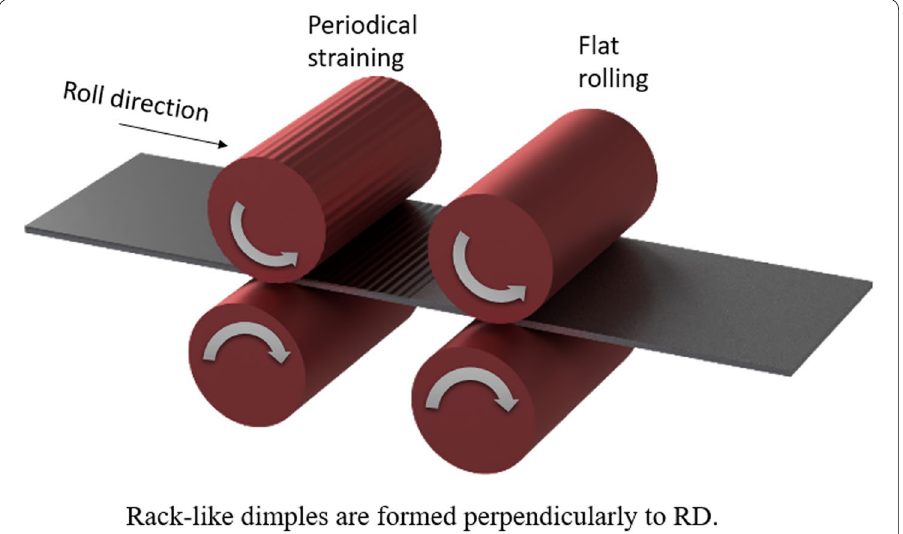
Fig. 6 Schematic illustration of the two stages of periodic straining rolling (PSR)